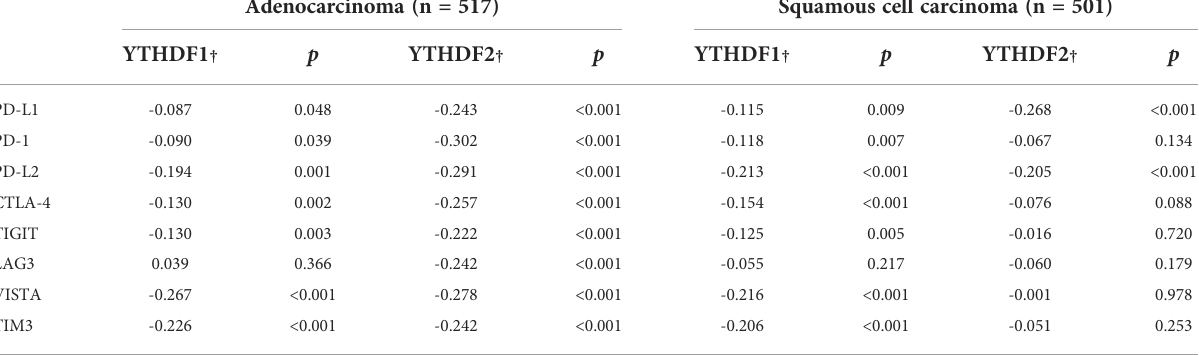
TABLE 5 Correlations between YTHDF1, YTHDF2 and immune checkpoints in mRNA expression